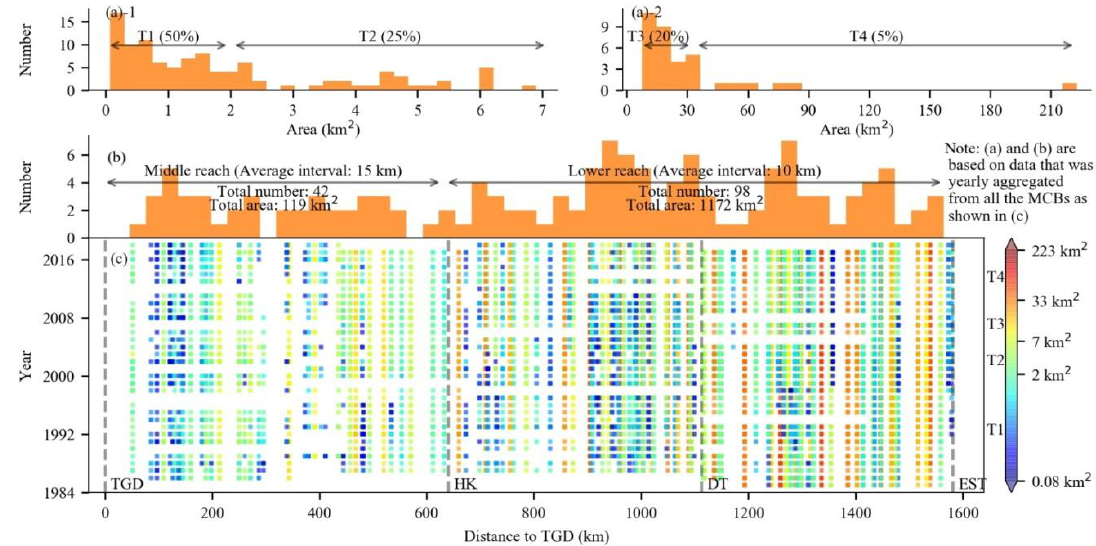
Figure 5. Overview patterns of MCBs extracted from Landsat images. Figures ( a )-1 and ( a )-2 are area histograms of MCBs with consecutive area ranges. ( b ) Distance-to-TGD histogram of MCBs, and ( c ) Longitudinal and temporal distribution of all MCBs (each dot represents a single MCB) with different sizes as indicated by their colors. T1, T2, T3, and T4 stand for four different MCB types as explained in Table 2.